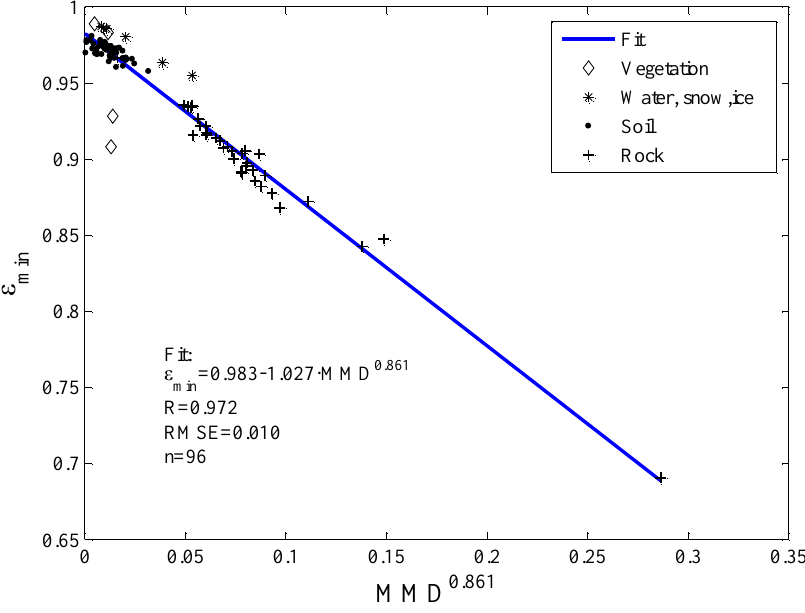
Figure 1. The empirical relationship between the 𝜀 R is the regression coefficient, RMSE is the root mean square error and n is the number of surface